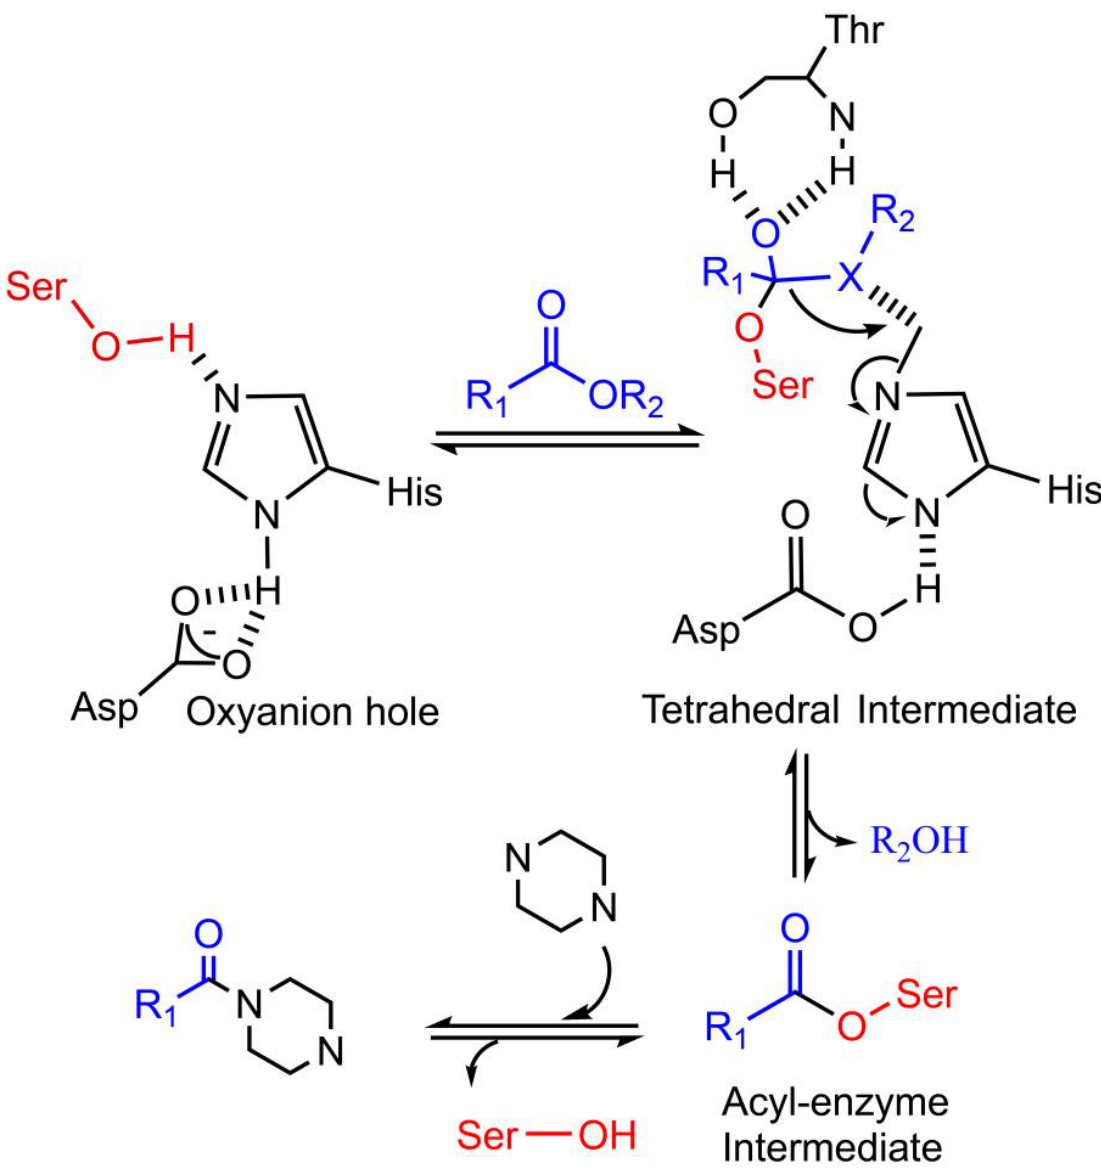
Figure 4. Mechanism of a speculated lipase/cutinase catalyzed amidation reaction towards piper- azine. The Ser-His-Asp catalytic triad center can activate the acyl donor to form a